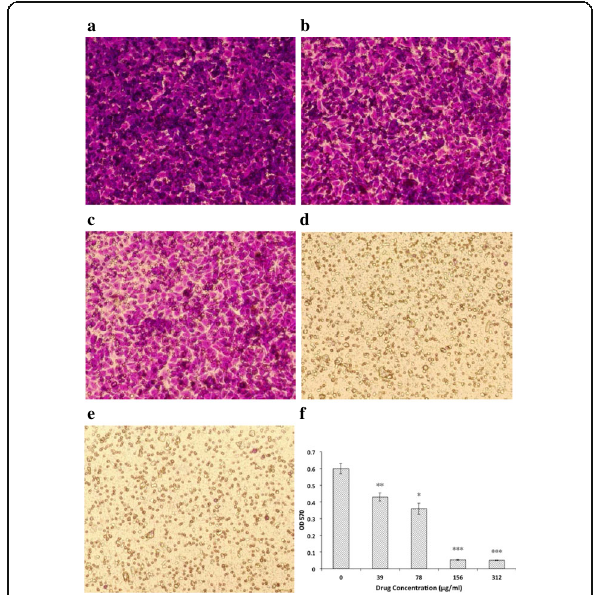
Fig. 3 Effect of oridonin on HUVEC migration. HUVECs were treated with various concentrations (39 – 312 μ g/ml) of oridonin. a control group; b 39 μ g/ml oridonin group; c 78 μ g/ml oridonin group; d 156 μ g/ml oridonin group; e 312 μ g/ml oridonin group; f OD570 comparison. The asterisks indicate statistically significant differences for oridonin groups compared with the control group (* P < 0.05, ** P < 0.01, *** P < 0.001)